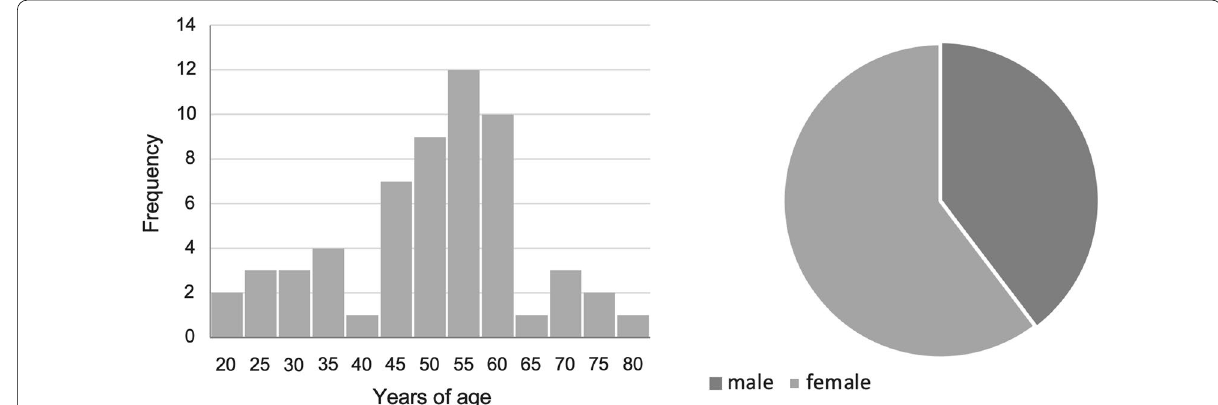
Fig. 4 Age (right) and gender (left) distribution of participants (left)